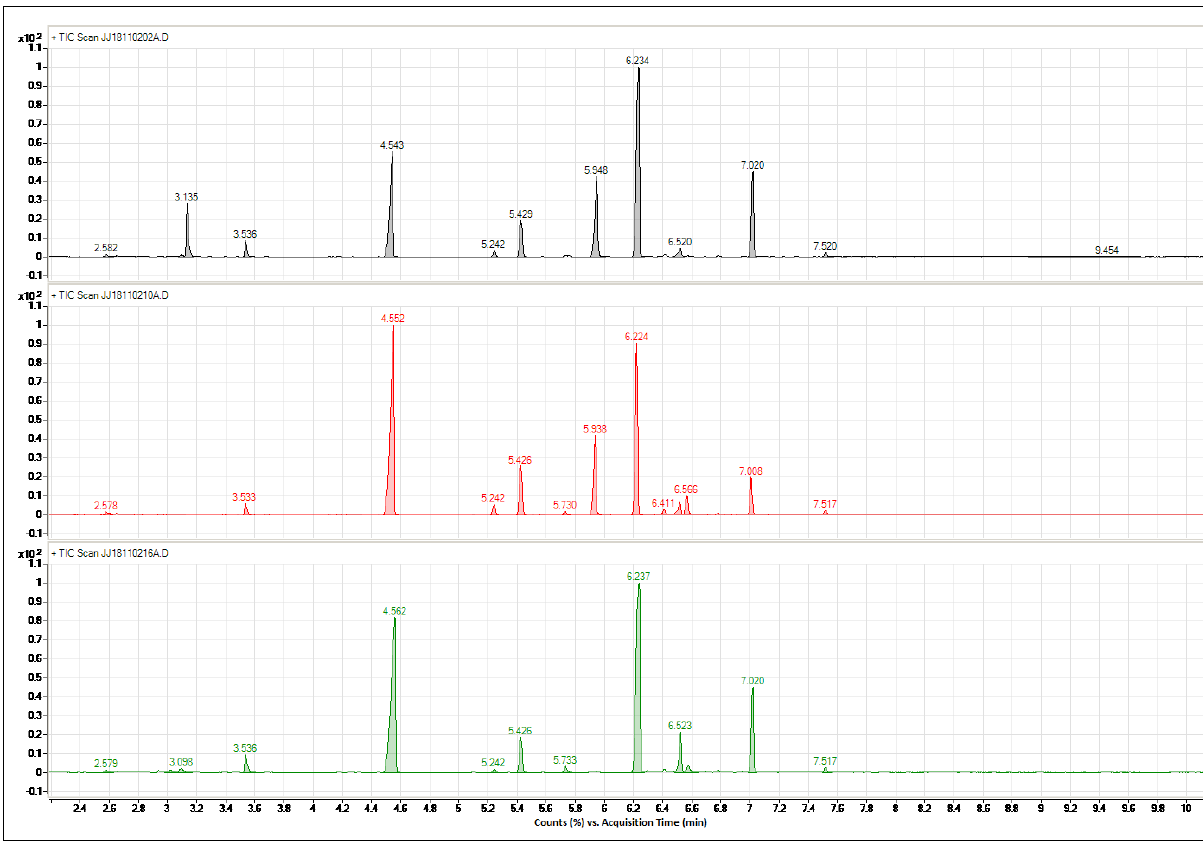
Figure 1: Exemplar chromatograms obtained by gas chromatography – mass spectrometry analysis of the three batches of simulated nyaope showing that it is possible to differentiate different batches of the drug, where identifications were (2.582) caryophyllene, (3.135) phenacetin, (3.536) caffeine, (4.543) efavirenz, (5.242) tetrahydrocannabivarin, (5.429) tetracosane IS, (5.733) cannabichromene, (5.948) nevirapine, (6.234) Δ 9 -THC, (6.411) cannabigerol, (6.520) cannabinol, (7.020) diamorphine, (7.520) nonacosane, (9.454) unknown in the first chromatogram.